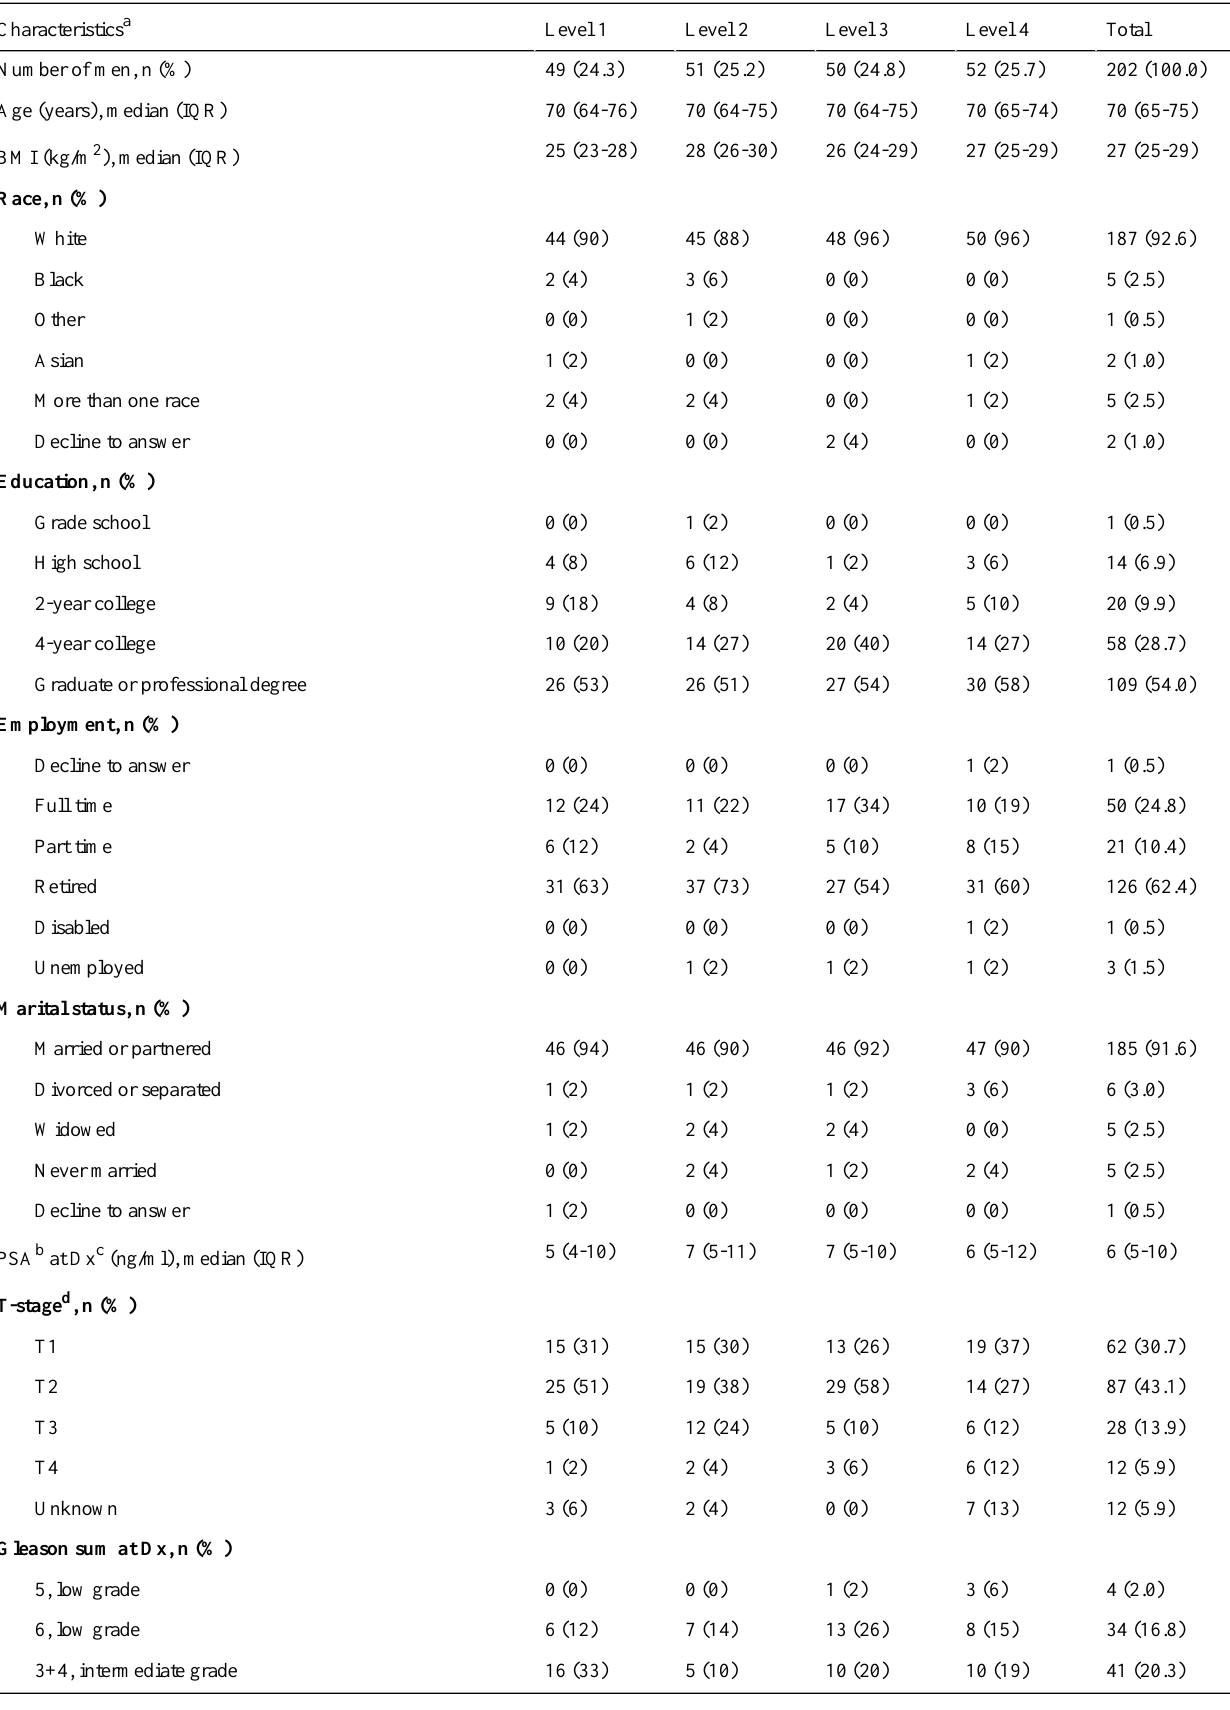
Table 1. Baseline self-reported sociodemographic and clinical characteristics of 202 men with prostate cancer participating in a technology-supported physical activity and dietary intervention, overall and by level